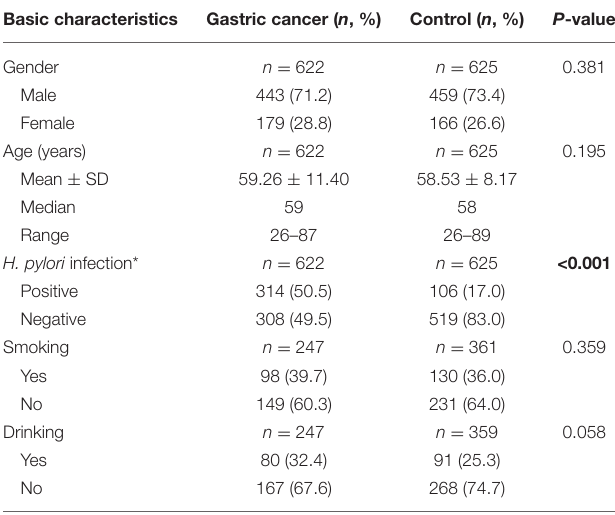
TABLE 1 | The basic characteristics of the study participants. Basic